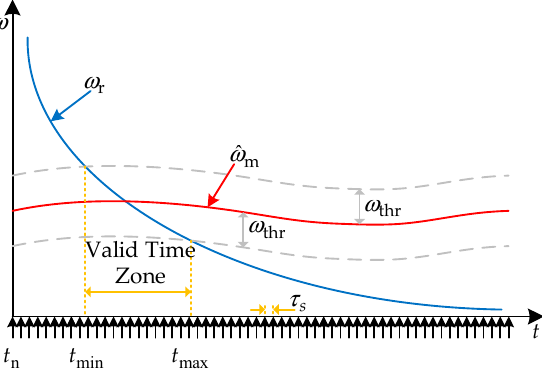
Figure 8. The valid time zone for the system state transition.